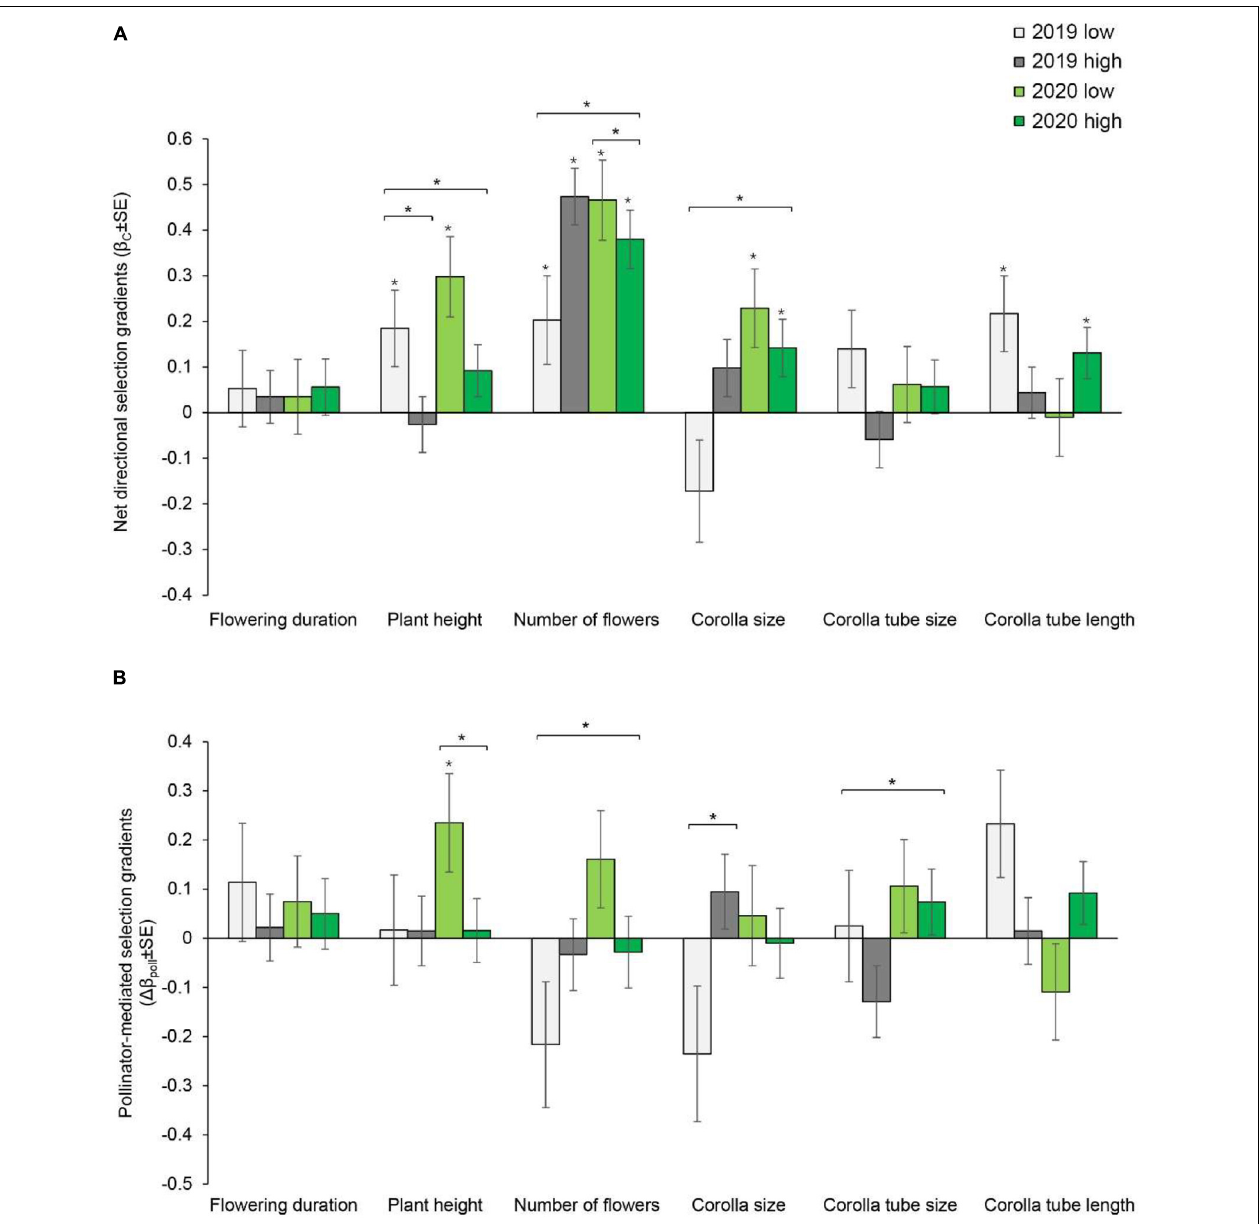
FIGURE 1 | Net directional selection gradients (A) and pollinator-mediated selection gradients (B) on flowering duration, plant height, number of flowers, corolla size, and corolla tube size and length in Primula tibetica at two sites (low and high soil water content sites). The symbols above the individual bars indicate the level of significance of the selection gradient. Symbols above the short lines spanning two gradients show whether ANCOVA indicated significant variation between sites in each year. Symbols above the long lines spanning several gradients show whether ANCOVA indicated significant variation between years. * P < 0.05.